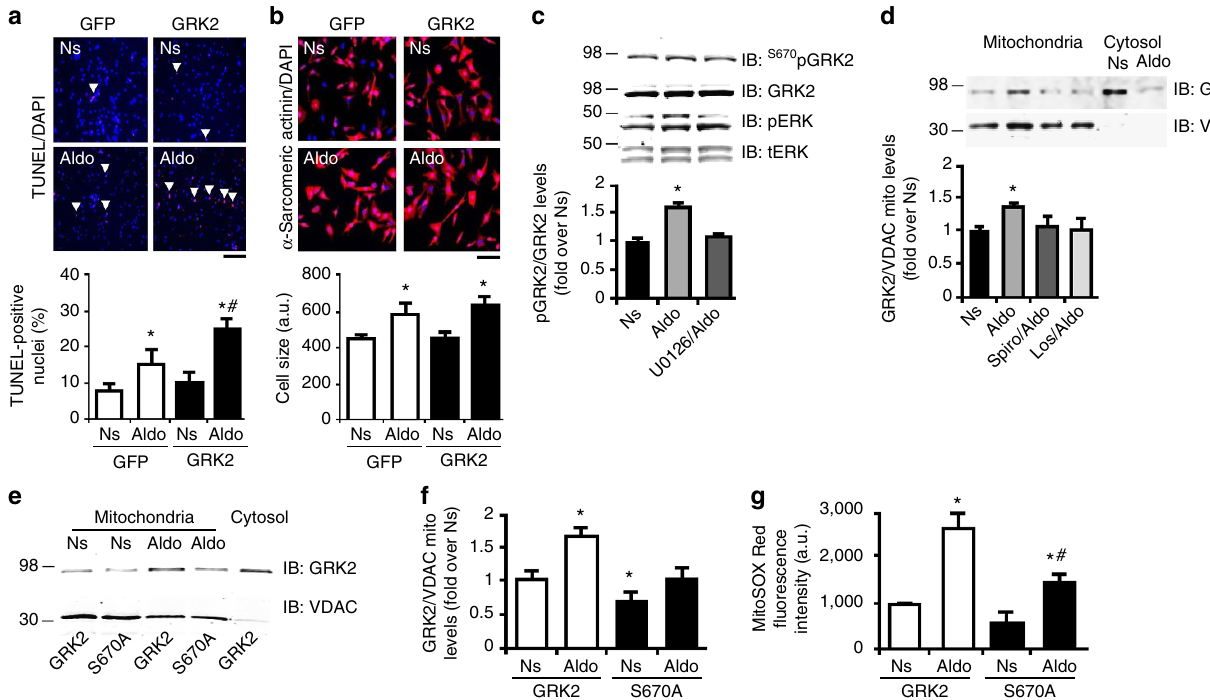
Figure 3 | Aldosterone-mediated GRK2 mitochondrial localization in myocytes. ( a , b ) Representative images and quantitative data from ( n ¼ 3) independent experiments showing ( a ) apoptotic (TUNEL staining; scale bar, 100 m m) NRVMs ( B 1,000 cells analysed for the group for each experiment) or ( b ) hypertrophic ( a -sarcomeric actin staining; scale bar, 50 m m) NRVMs ( B 200 cells analysed for the group for each experiment) infected with either Ad-GFP or Ad-GRK2 to determine the effect of Aldo with GRK2 overexpression. Myocytes were unstimulated (Ns) or stimulated with Aldo (1 m M) for 24 ( a ) or 48h ( b ). * P o 0.05 versus GFP Ns; # P o 0.05 versus GFP Aldo. ( c ) Representative immunoblots (upper panels) and densitometric quantitative analysis (lower panel) of multiple ( n ¼ 3) independent experiments to evaluate GRK2 phosphorylation (ser670) or ERK 1/2 phosphorylation (pERK) levels in NRVMs Ns or stimulated with Aldo (1 m M) for 15min. Before Aldo, a group of cells was pre-treated with U0126 (3 m M) for 30min. Total ERK (tERK) and GRK2 are shown as loading controls; * P o 0.05 versus Ns. ( d ) Representative immunoblots (upper panels) and densitometric quantitative analysis (lower panel) of multiple ( n ¼ 3) independent experiments to evaluate GRK2 levels in mitochondrial fractions purified from NRVMs that were either Ns or stimulated with Aldo (1 m M) for 30min. Before Aldo, a group of cells was pre-treated with Spiro (10 m M) or Los (10 m M) for 30min. VDAC was used as loading and mitochondrial purity control; * P o 0.05 versus Ns. ( e , f ) Representative immunoblots ( e ) and denistometric quantitative analysis ( f ) of multiple ( n ¼ 3) independent experiments to evaluate GRK2 levels in mitochondrial fractions purified from NRVMs infected with Ad-GRK2 and Ad-GRK2-S670A that were either Ns or stimulated with Aldo (1 m M) for 30min. VDAC was used as loading and mitochondrial purity control; * P o 0.05 versus GRK2 Ns. ( g ) Cumulative fluorescence data from ( n ¼ 3) independent experiments of MitoSOX Red staining of NRVMs ( B 200 cells analysed for the group for each experiment) infected with adenoviruses encoding for either GRK2 or GRK2-S670A. Myocytes were then Ns or stimulated for 30min with Aldo. * P o 0.05 versus GRK2 Ns; # P o 0.05 versus GRK2 Aldo. ( a – d , f , g ) Statistical significance between groups was determined by one-way ANOVA with Bonferroni post hoc correction. All data are shown as mean ± s.e.m. NATURE COMMUNICATIONS|7:10877|DOI: